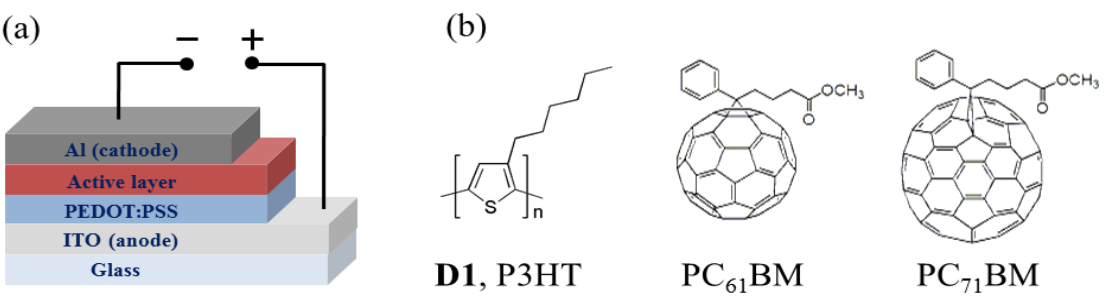
BM, and PC 61 71